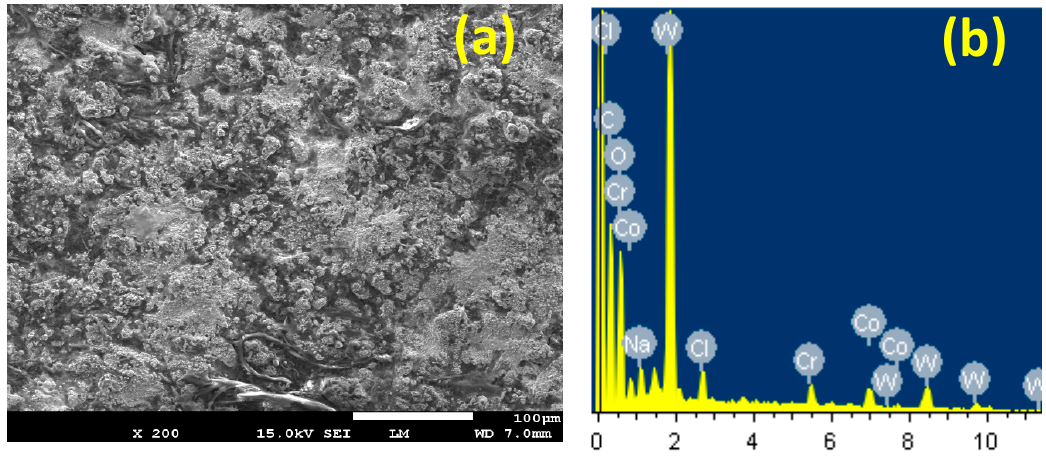
Figure 13. ( a )The SEM image and ( b ) the corresponding EDX spectra for PS coated with 86%WC-10%Co-4%Cr in 4% NaCl solution for 48 h followed by fixing a potential value of − 700 mV for 40 min.